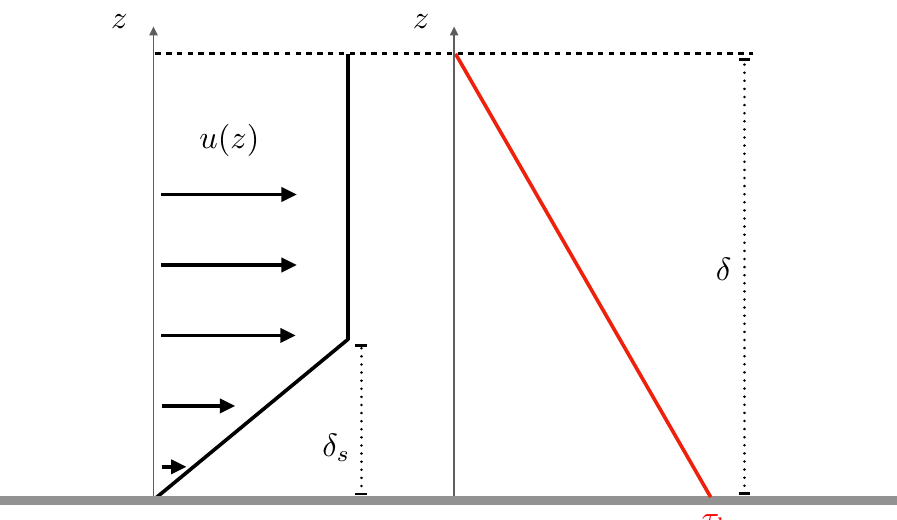
Figure 1. Schematic of idealized distribution of velocity and shear stress in the non-rotating bottom boundary layer (BBL). On the left is the mean velocity profile as a function of depth, where a constant shear layer of thickness δ s is present. On the right is the linearly decaying profile of shear stress, where it takes the bottom stress value τ = τ b at z = 0 and τ = 0 at z = δ . The vertical profiles of velocity and shear stress in the DNS of non-rotating BBL are shown in Figure 2 for two different Re τ . Supporting the main idealization associated with our heuristic model introduced above, two observations can be made: (i) the largest velocity shear is confined within a thin layer near the bottom (Figure 2a and dashed lines in Figure 2b); (ii) the decay of the total shear stress follows a rather linear profile (solid lines in Figure 2b). As Re τ increases, the layer accounting for the large velocity shear becomes thinner and closer to the wall. While the shear layer thickness is always thinner than δ , and progressively more so for increasing Re τ , it clearly differs from the limit where the shear layer is infinitesimally thin, as assumed in Taylor’s formula. We will evaluate the impact of this discrepancy in the next section.